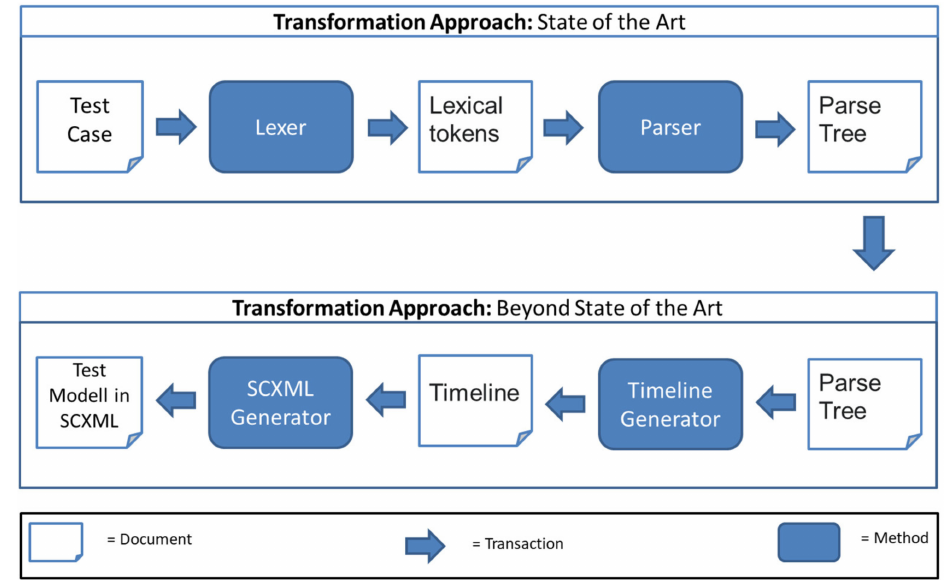
Figure 6. Transformation Approach, adapted from